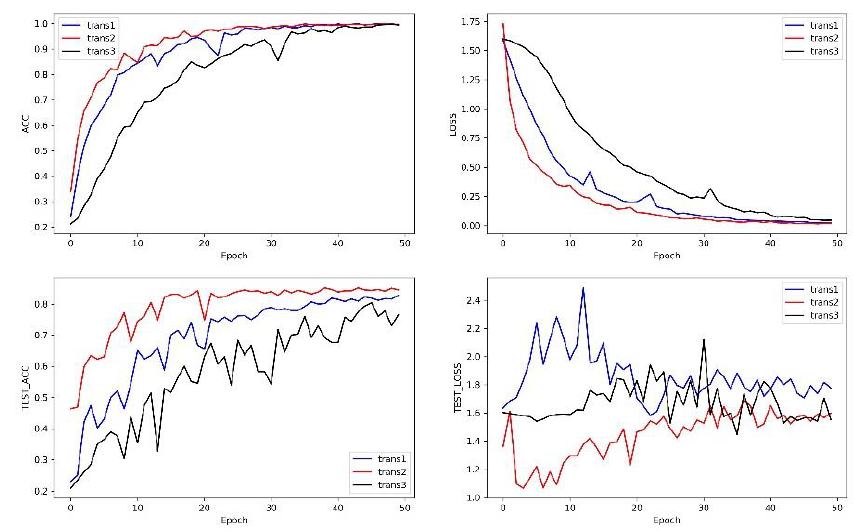
Figure 20. Comparison of three transfer methods under 0.625 data size.